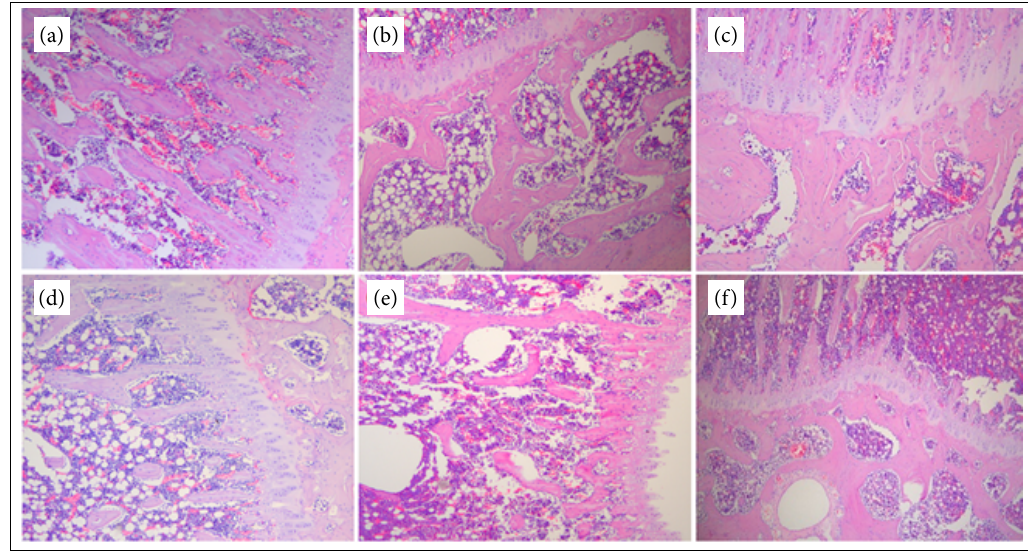
Figure 1 - Hematoxilin and eosin (HE) staining of rat tibia (HE ×40). (a) Control group; (b) model group; (c) Alendronate sodium group; (d) PRR group; (e) RA group; (f) PRR + RA group.